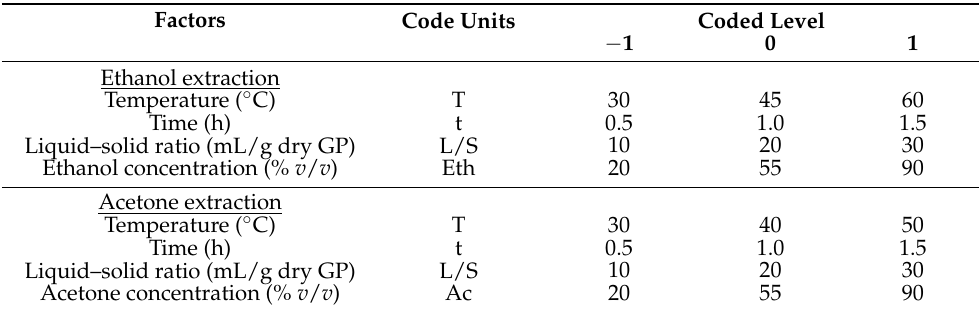
Table 5. Experimental values and coded levels of the independent variables tested in the central composite